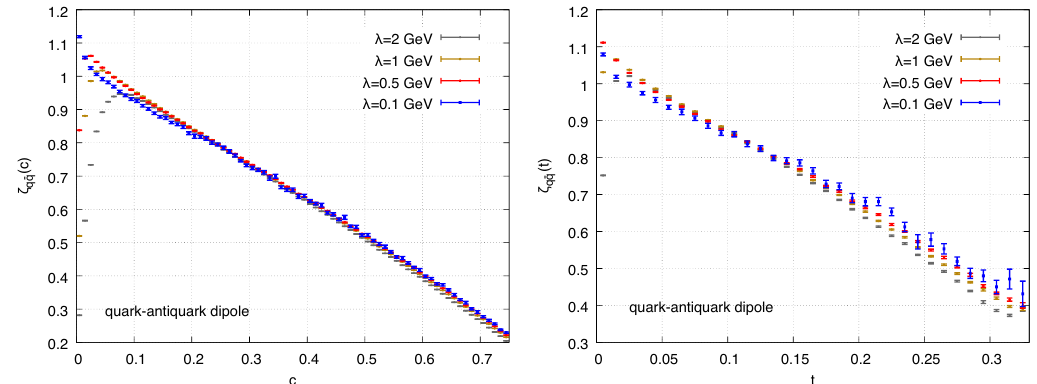
Figure 4 . The function ζ q ¯ q ( c ) for the C -parameter and for thrust t = 1 − T , obtained using Q = 100 GeV and λ = 2 GeV, λ = 1 GeV, λ = 0 . 5 GeV and λ = 0 . 1 GeV. The normalization